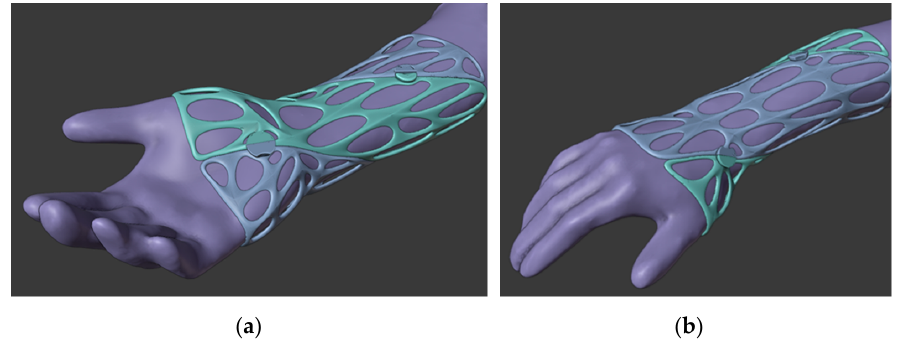
Figure 5. Three-dimensional models of the braces in Blender ( a ) palmar view of the forearm and ( b ) dorsal view of the forearm.